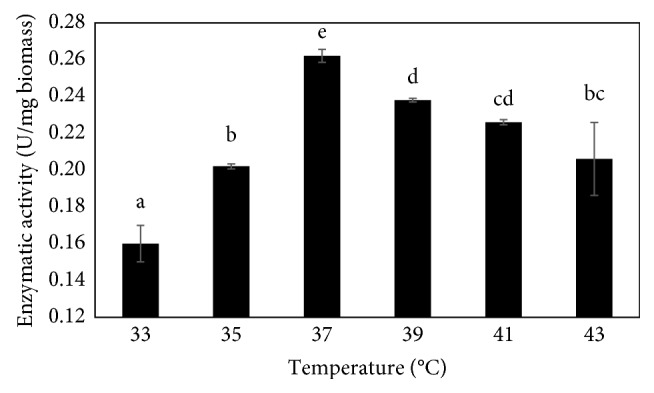
The effect of temperature on glucose isomerase production. Enzyme activity was increased along with an elevation of temperature from 33°C to 37°C (p < 0.05). When the temperature increased over optimal temperature (39°C–43°C), the enzyme activity dramatically decreased from 0.238 ± 0.001 to 0.206 ± 0.020 U/mg biomass (p < 0.05). From these data, we chose 37°C as the optimal temperature for glucose isomerase production. a, b, c, d, and e indicate the significant difference between groups.